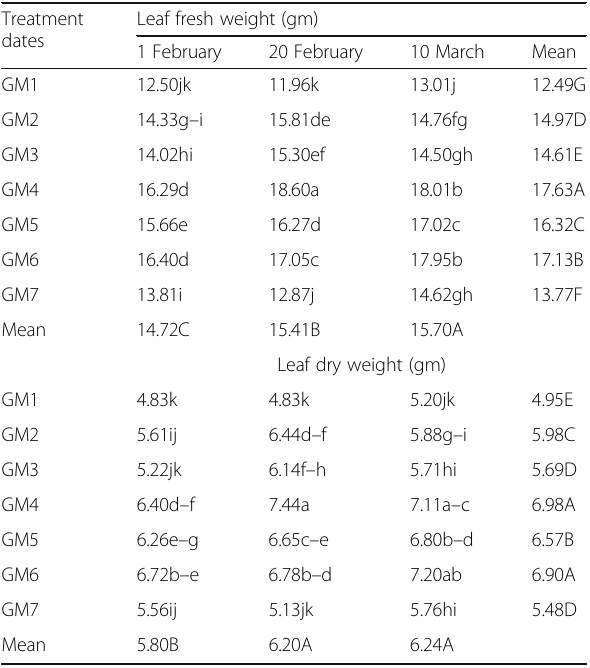
Table 6 Effect of planting dates and different growing media and the interactions between them on leaf fresh and dry weight of pistachio seedlings Treatment dates